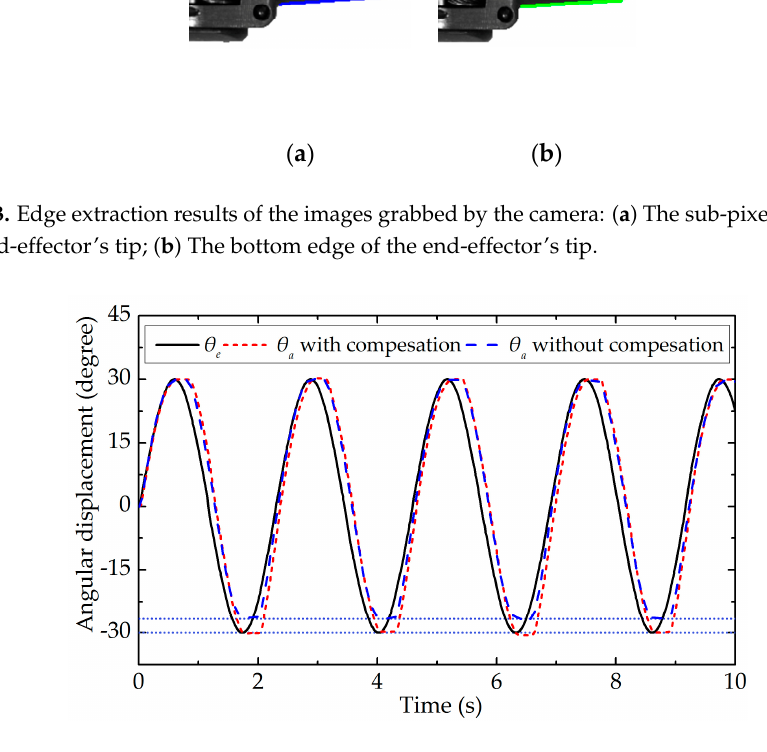
Figure 14. Comparison between the actual angular displacement of the end-effector with and without position compensation.